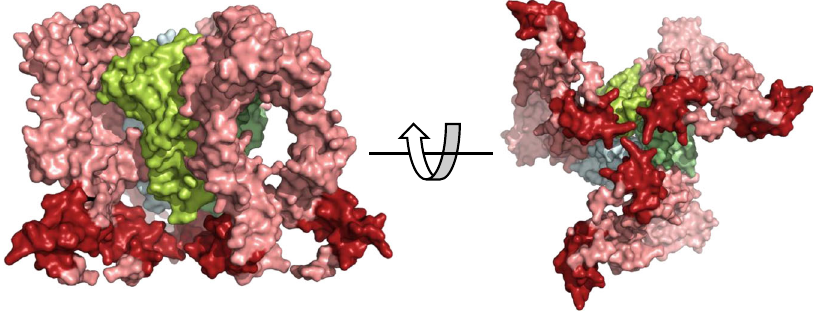
Fig. 7 Model of TNF with long-form TNFR1 (41 – 201) dimers bound. Side and bottom view of surface rendered trimeric TNF (green) with three copies of long-form TNFR1 (41 – 201) dimers bound (pink). The fourth cysteine-rich domain of each receptor is highlighted in